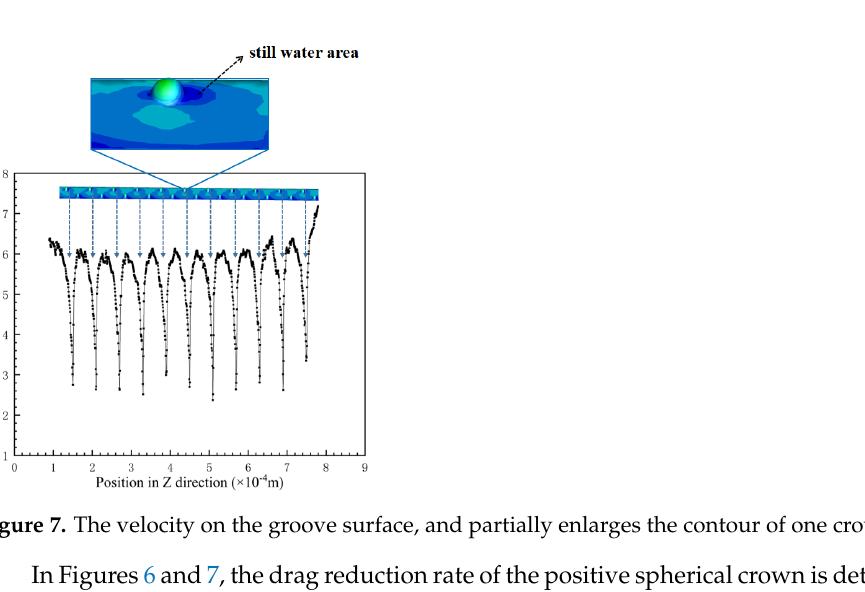
Figure 9. The turbulent kinetic energy which perpendicular to flow direction. From ( a – e ), the height of the positive spherical crown changes from +4 μ m to +0.8 μ m. 3.2. Negative Spherical Crown Structure